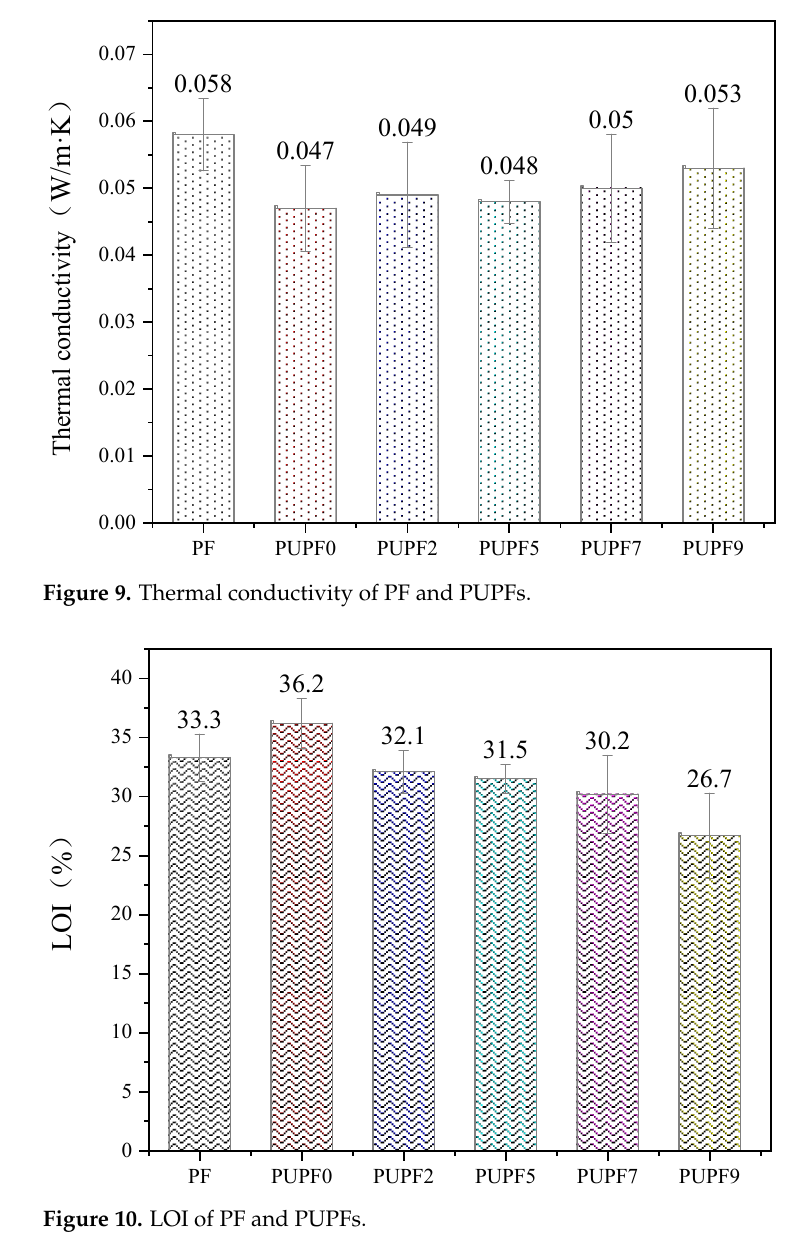
Figure 10. LOI of PF and PUPFs. According to ASTM E-1354, the combustion performance of the samples was tested at a radiation power of 50 kW/m 2 using 100 mm × 100 mm × 5 mm samples. The test pa- rameters included ignition time ( T TI ), peak heat release rate ( P HRR ), total heat release ( T HR ), average specific extinction area ( A SEA ), and average mass loss rate ( A MLR ). Table 5 shows that adding the PU prepolymer decreased the flame-retardant properties of the foam, which is consistent with the LOI test results. If the ignition time of the material is longer,